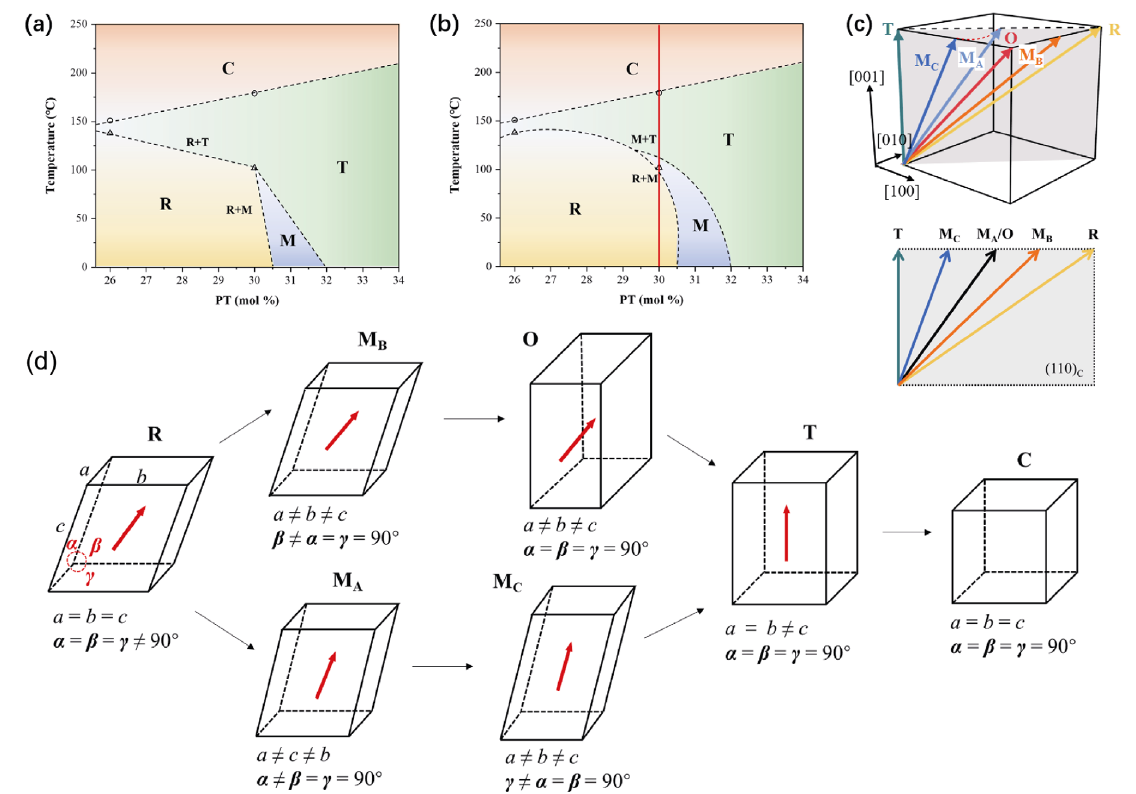
Fig. 6 Schematic phase diagram of CF BM PINMT system of (a) DCP and (b) ACP; (c) possible polarization vectors of low symmetry phases (M A , M B , M C , and O), R and T phases in perovskite crystals, and polarization projection on the (110) pc plane; and (d) illustration of lattice deformations for the two paths of phase transition from RT to HT over T C